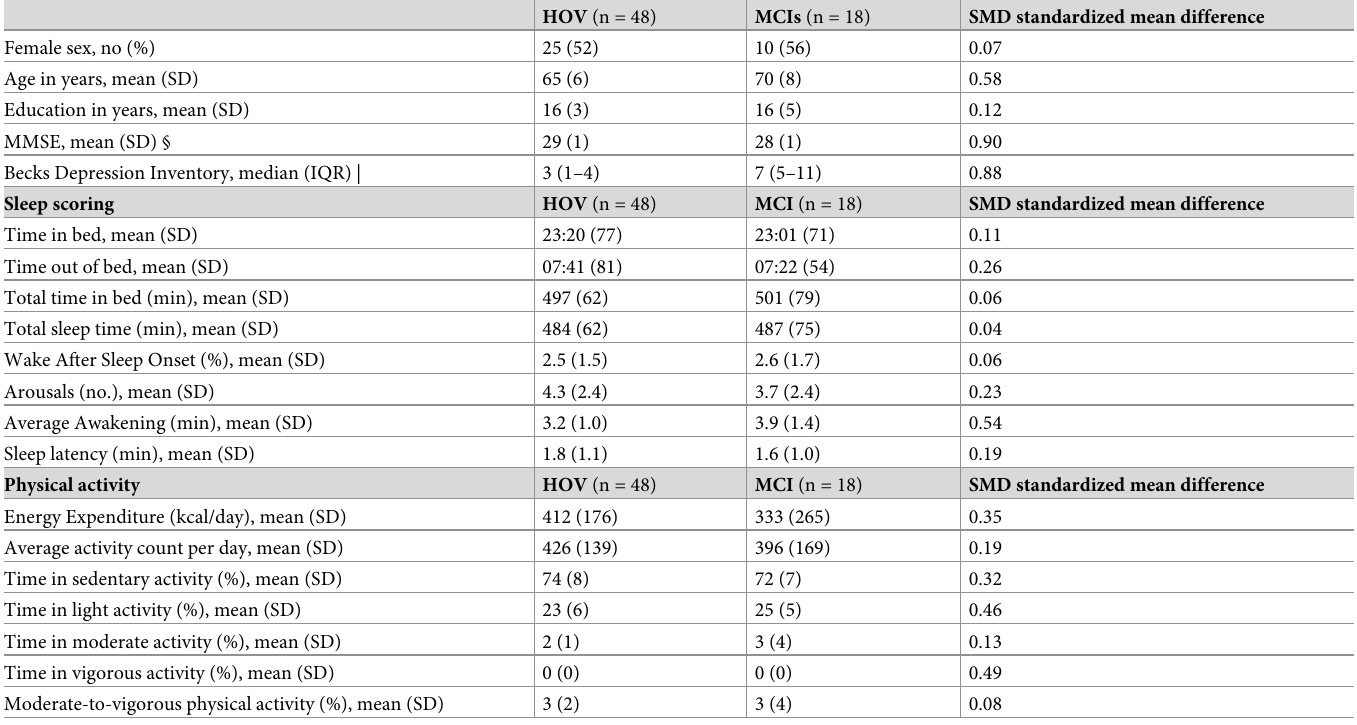
Table 1. Baseline characteristics and aggregated descriptive accelerometer data for HOV and MCI. HOV (n = 48) MCIs (n = 18) SMD standardized mean